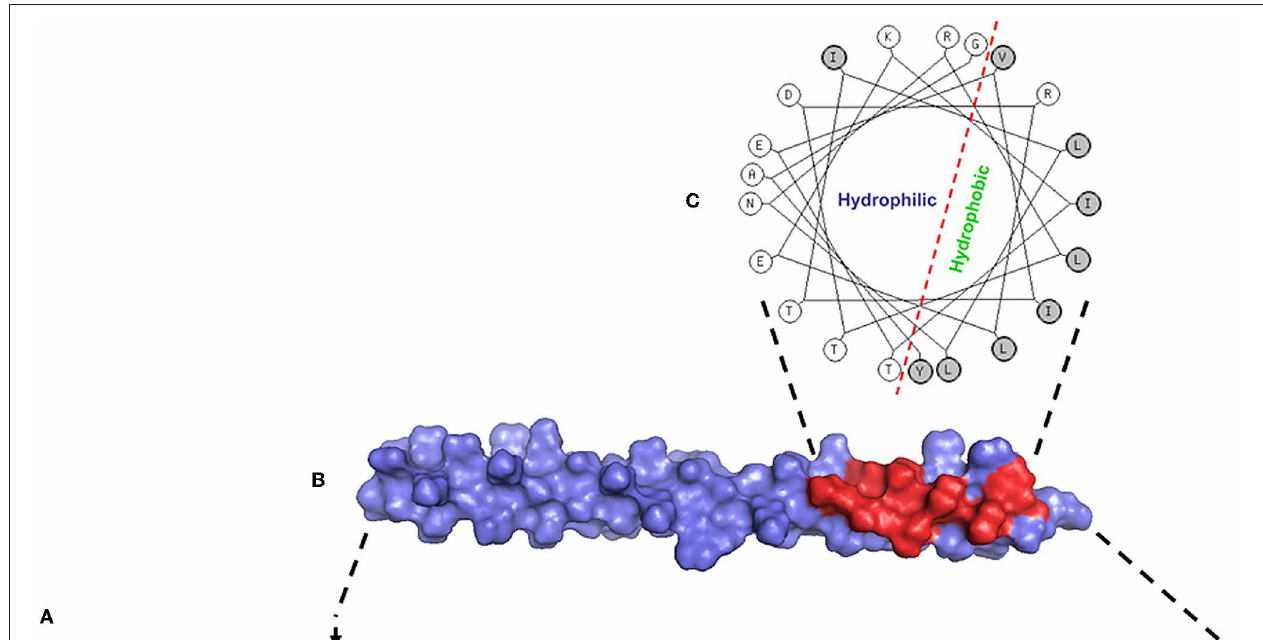
FIGURE 1 | (A) Primaryaminoacid sequenceofthearchetypalHDMsecreted by Fasciolahepatica ,FhHDM-1.TheN-terminalsignalpeptideisshowninitalics andthepredictedsecondarystructure(predominantlyalphahelix)isshown